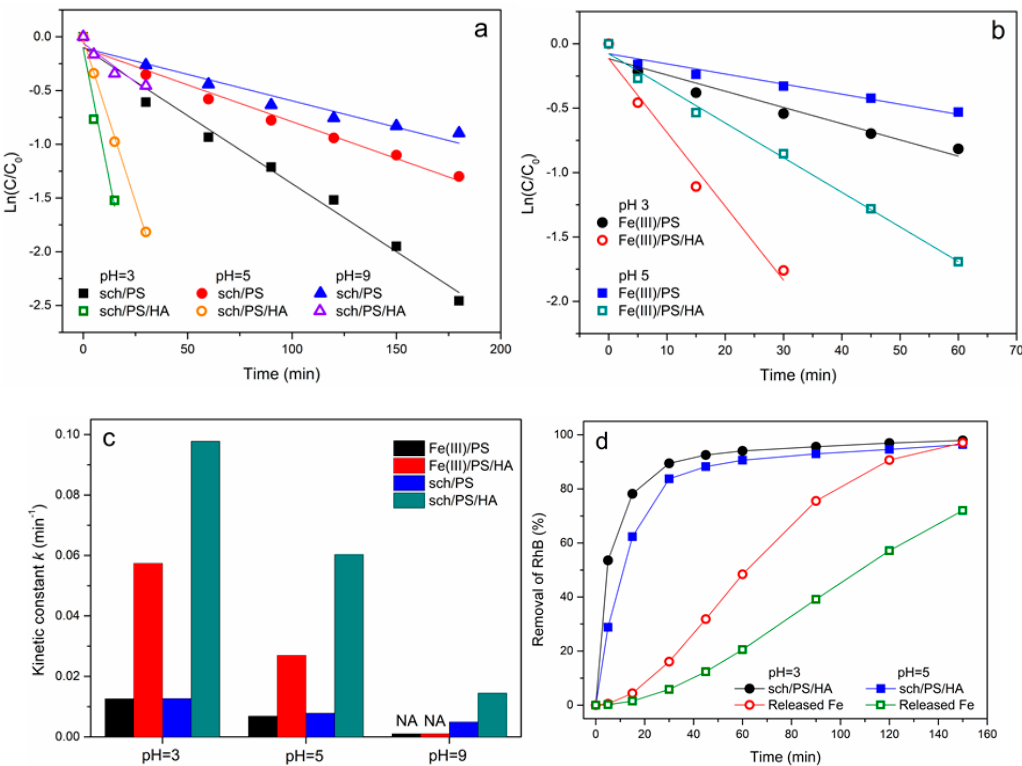
Figure 6. First-order kinetics of RhB degradation in homogeneous and heterogeneous oxidation processes under various pH conditions. Initial RhB degradation rates in: ( a ) Sch/PS and Sch/PS/HA; and ( b ) Fe(III)/PS and Fe(III)/PS/HA. ( c ) Effect of HA on initial RhB degradation rates. ( d ) Effect of released iron by the reductive dissolution during the heterogeneous oxidation process.